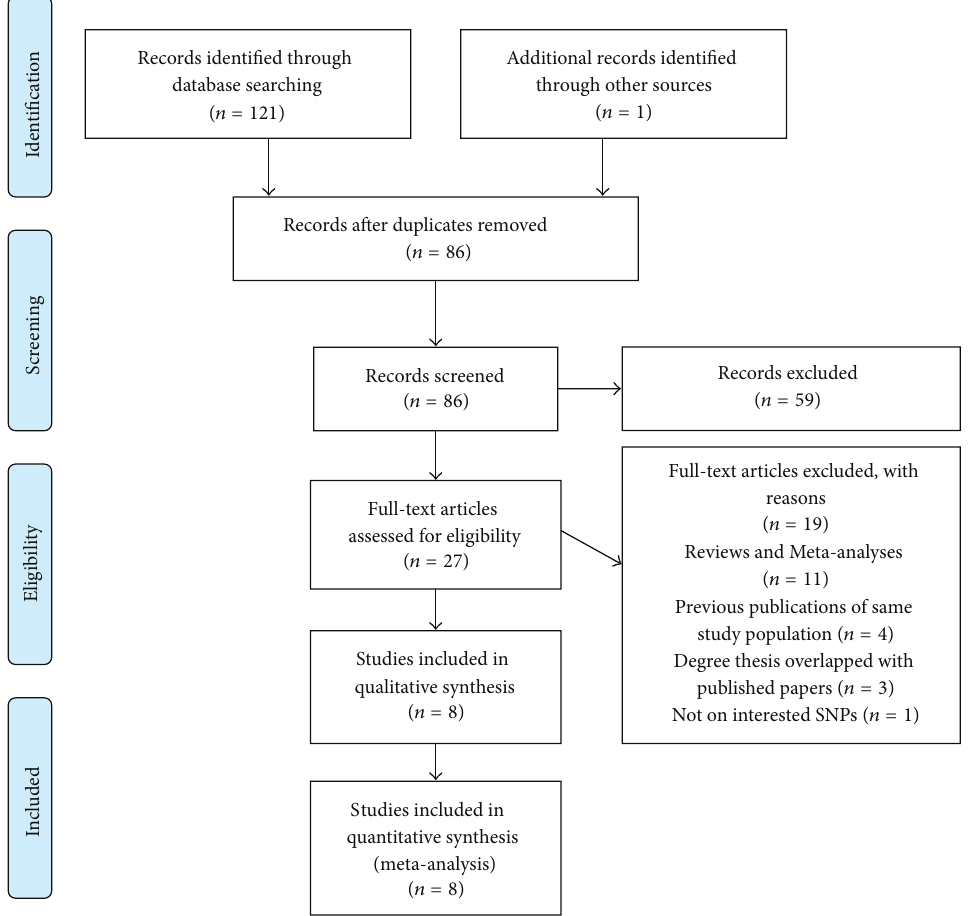
Figure 1: Flow diagram of literature search and